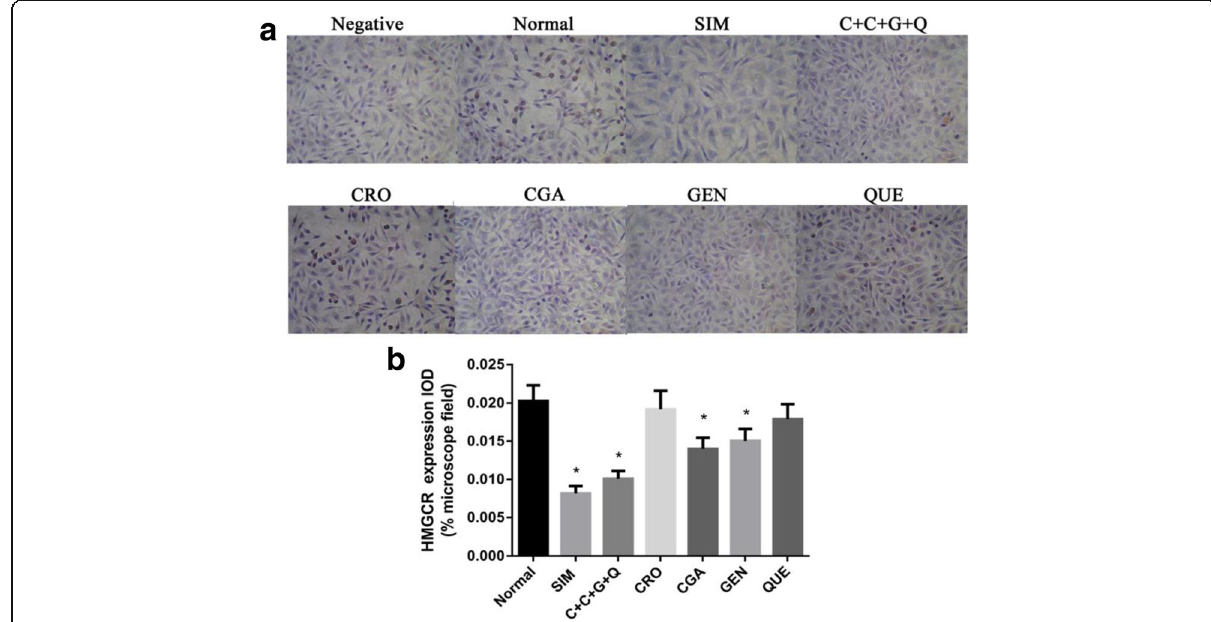
Fig. 5 Expression of HMGCR in HepG2 cells. a Representative immunocytochemical images of HMGCR expression in cells. HepG2 cells were treated with SIM (10 μ mol/L), C + C + G + Q (1 μ mol/L + 30 μ mol/L + 10 μ mol/L + 10 μ mol/L), CRO (1 μ mol/L), CGA (30 μ mol/L), GEN (10 μ mol/L) and QUE (10 μ mol/L) for 48 h respectively, and treated with PBS instead of the primary antibody of HMGCR for negative control, and with no drug for normal control. The brown granules in the cytoplasm represent HMGCR positive staining results. b The bar chart showing the comparison of the IOD for HMGCR expression in cells. Data represent as mean ± SEM of three independent experiments. * P < 0.05 vs. control, # P < 0.05 vs. SIM